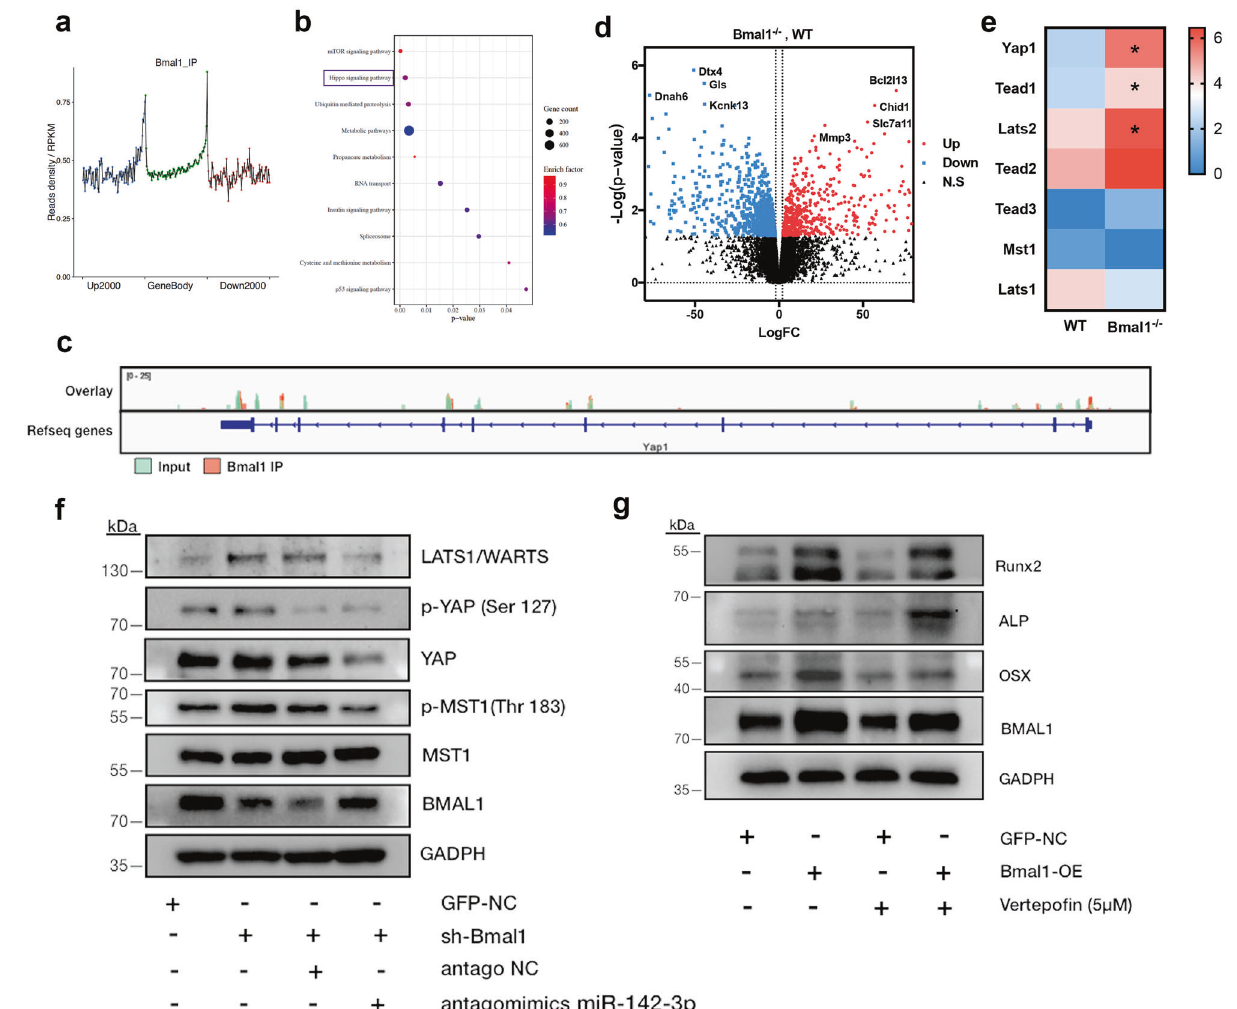
Fig. 4 Bmal1 promotes BMSCs osteogenesis via miR142-3p/Bmal1/YAP axis. a , b Bmal1 binding regions related to the gene body and enriched KEGG pathways for Bmal1 mediated biological process by ChIP-seq. The box indicated the enriched Hippo pathway ( p = 0.002, enrich factor = 0.668). c ChIP tracks viewed by the integrated Genome Viewer (IGV) revealed that Bmal1 has high enriched peak at YAP coding region. d Volcano map of differential expressed mRNAs pro fi le in Bmal1 − / − and wildtype BMSCs, based on GSE106586 dataset. e Heat map of Hippo pathway genes expression in Bmal1 − / − and wildtype BMSCs. * p < 0.05. f Western blot analysis of Hippo pathway components (LATS1/ WARTS, p-MST1, MST1, p-YAP, YAP) in Lv-shRNA-Bmal1 and mock vectors (short for sh-Bmal1 and GFP-NC) transfected OriCell C57/BL6 BMSCs, then rescued by transfected miR142-3p antagomimics. g Western blot analysis of osteogenesis related genes (RUNX2, ALP, OSX) in Bmal1/OE and mock vectors transfected OriCell C57/BL6 BMSCs and Vertepor fi n (5 μ M) treated cells after fi ve days osteogenic groups compared with the GFP and miRNA/NC groups (Fig. 5d). Histological analysis showed that larger new bone area was observed in clock-modi fi ed BMSCs groups, which con fi rmed the osteogenic capability of Bmal1-overexpressing and miR-142-3p- inhibited BMSCs in vivo (Fig. 5e). TRAP staining showed that osteoclasts at the border of the new bone were highly active in the Baml1/OE and miR-142-3p/inhibitor groups (Fig. 6a, b). Immunostaining demonstrated that more ALP-expressing cells appeared in the new bone in the Bmal1/OE and miR-142-3p groups than in the other groups, and GFP + cells and mCherry + cells indicate Bmal1/OE and miR-142-3p/inhibitor BMSCs, respec- tively (Fig. 6c). In addition, the transplanted cells showed strong ALP expression near the newly formed bone, which indicated that the donor cells might also contribute to osteoblast lineage commitment in vivo. We further performed IHC analysis to investigate the expression level of YAP and p-YAP in newly generated bone. As shown in Fig. 6d, e, the expression level of YAP were signi fi cantly decreased in miR-142-3p/inhibitor and